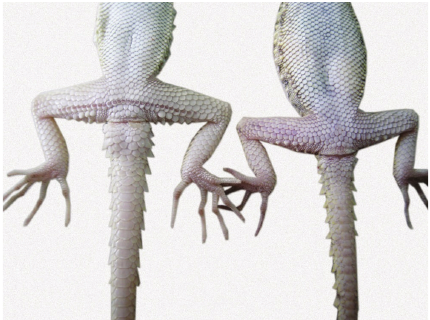
Figure 2: The ventral surface of T. caspius . Femoral and preanal pores are present in males, the left side one Babaei Savasari,